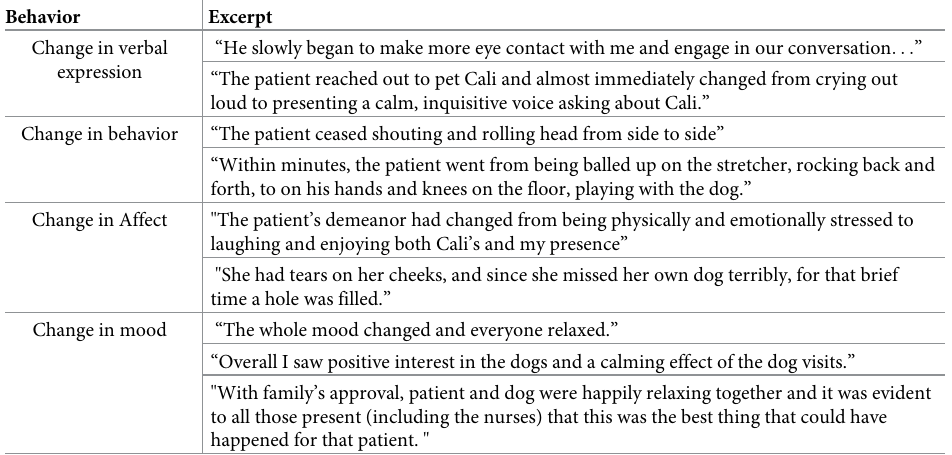
Table 4. Excerpts from field notes of therapy dog handlers regarding patient behaviors. Behavior